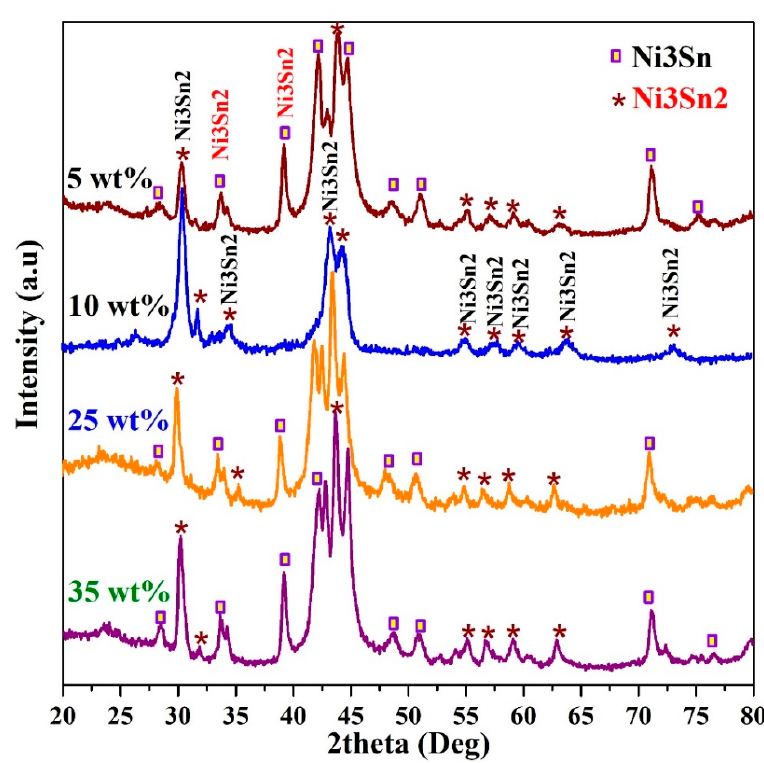
Figure 2. XRD analysis of the Sn-incorporated Ni/C nanofibers synthesized at 850 °C calcination temperature.